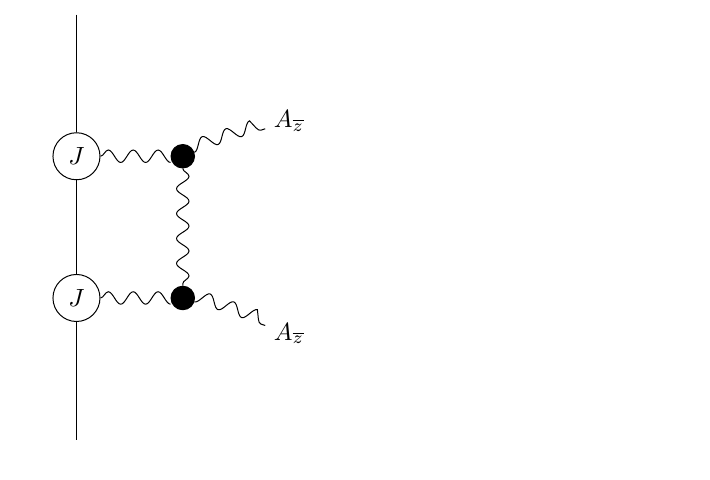
Figure 4 . This diagram has a gauge anomaly leading to a quantum correction of the chiral